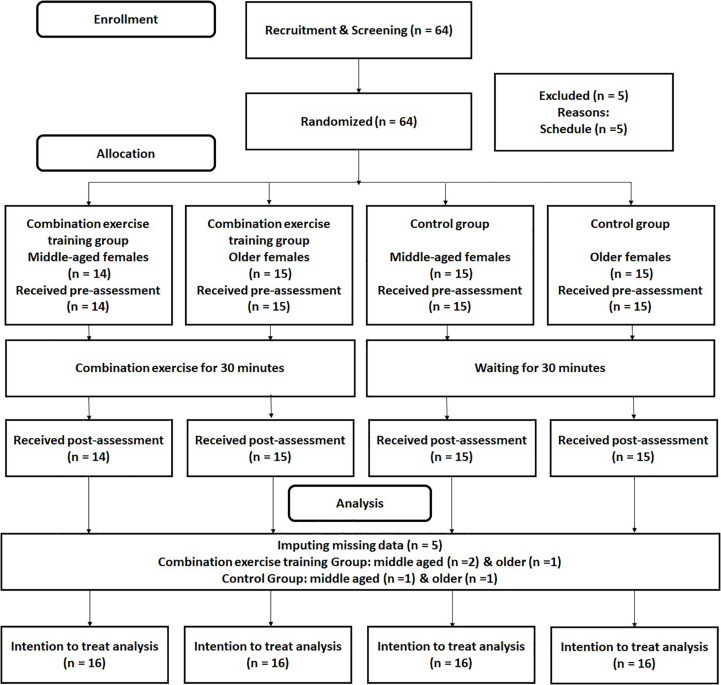
CONSORT diagram.